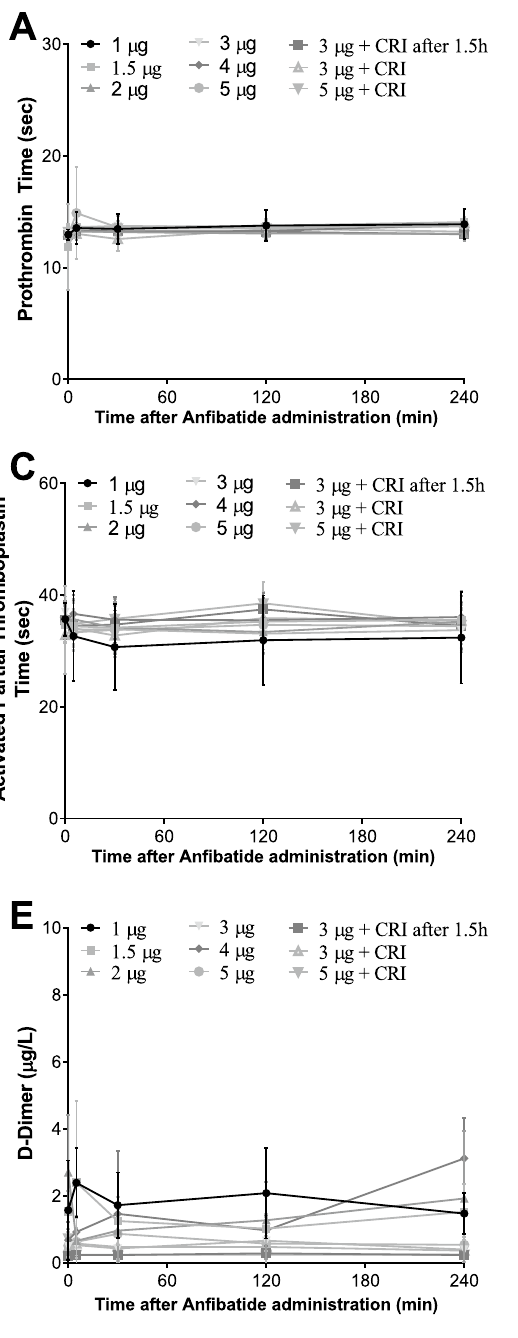
Figure 7. Anfibatide had no significant effect on coagulation measured by prothrombin time ( A ), thrombin time ( B ), activated thromboplastin time ( C ), and international normalized ratio ( D ). anfibatide did not significantly change circulating d-dimers ( E ), representing fibrinolysis. (CRI indicates constant rate infusion). Mean ±